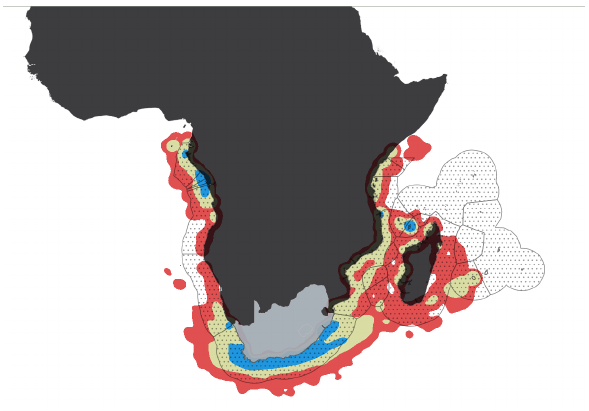
Figure 9. SAR Ship Detections in 2020. Where Blue, Yellow and Red represent High, Medium, Low vessel detections respectively.